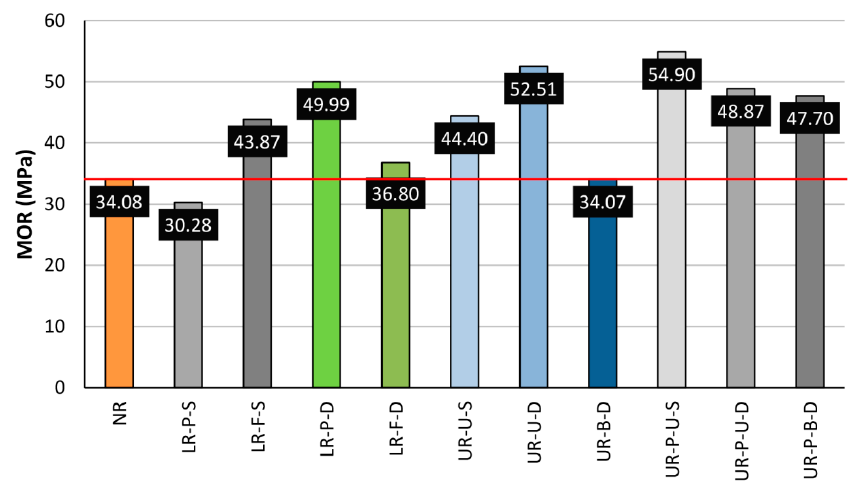
Figure 22. Average MOR for each beam group. Horizontal red line: Average MOR for NR beams.